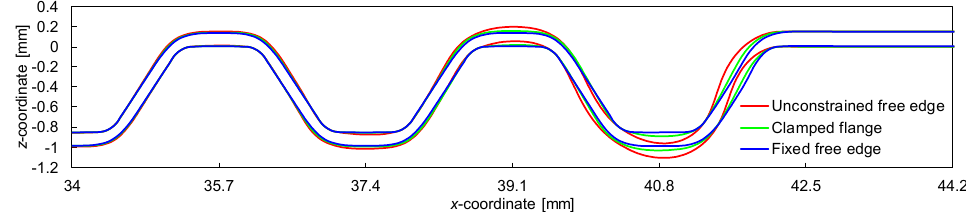
Figure 7. Cross-section of the BPP (2 channels closest to the flange) using three different boundary conditions in the flange region and considering plane strain conditions.